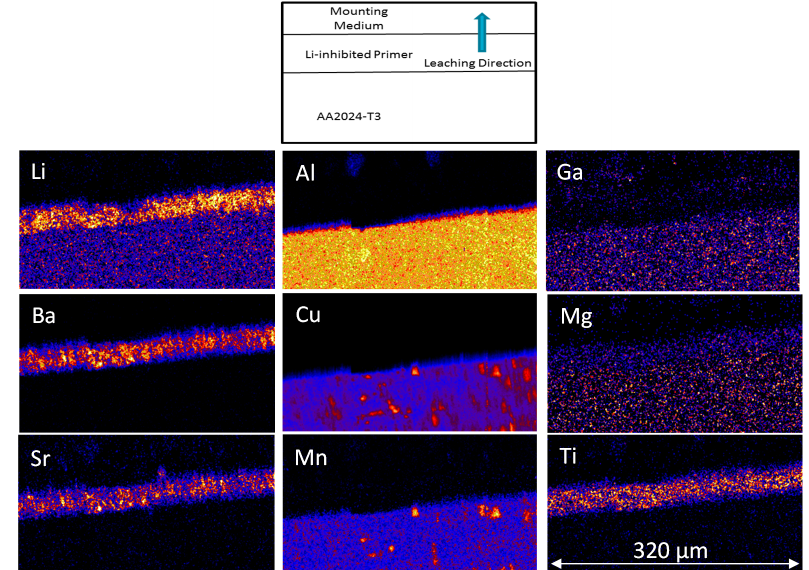
Figure 7. Combined PIXE and PIGE maps for a sample that has not been exposed to NSS. The PIGE maps (Li ‐ PIGE and Al ‐ PIGE) are labelled as such, and the rest are PIXE maps. The schematic on the top shows the sample configuration and indicates the direction and interface from which leaching has occurred. The colour scale is thermal, with warm colours representing higher concentrations.